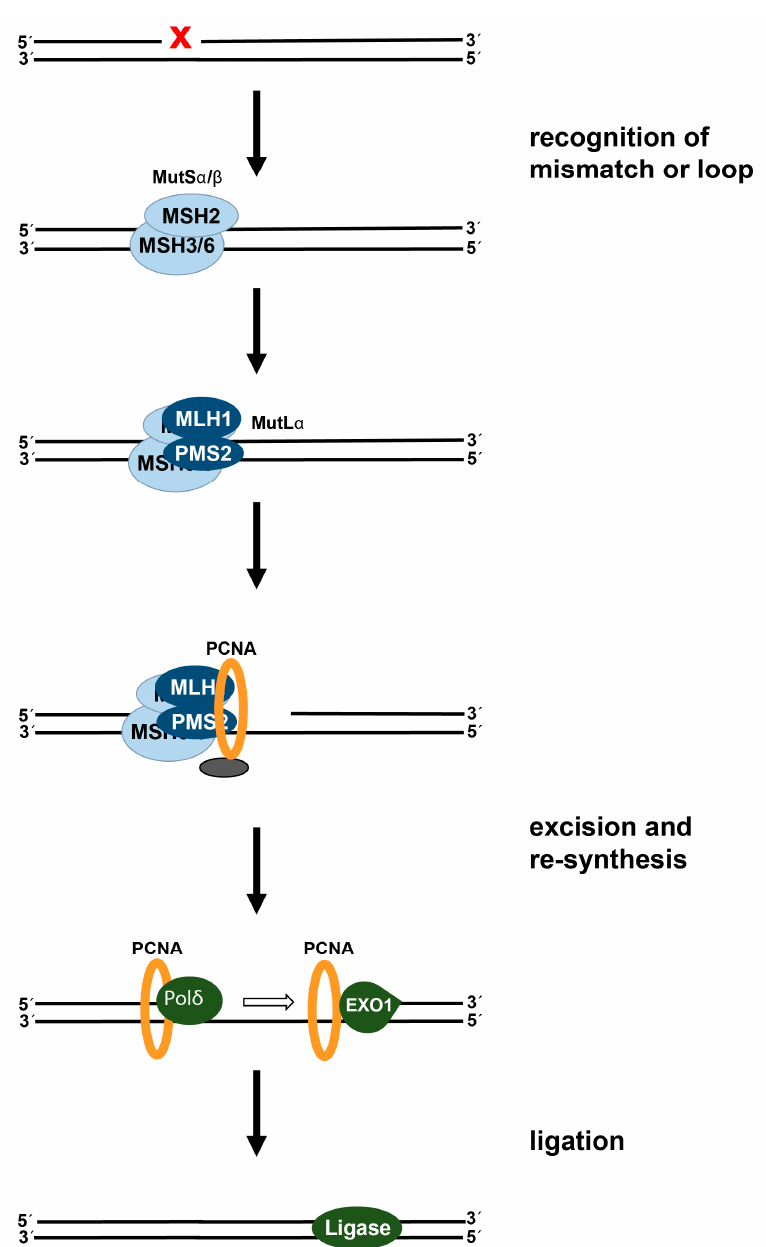
Figure 3. Mechanism of human mismatch repair. In addition, hMutS α /hMutS β detect and bind to DNA mismatches or small loops. The hMutL α is recruited, followed by RFC-mediated loading of PCNA onto DNA. EXO1 binds and catalyzes excision of nucleotides beyond the mismatch/loop, followed by Pol δ -catalyzed re-synthesis and DNA ligation.